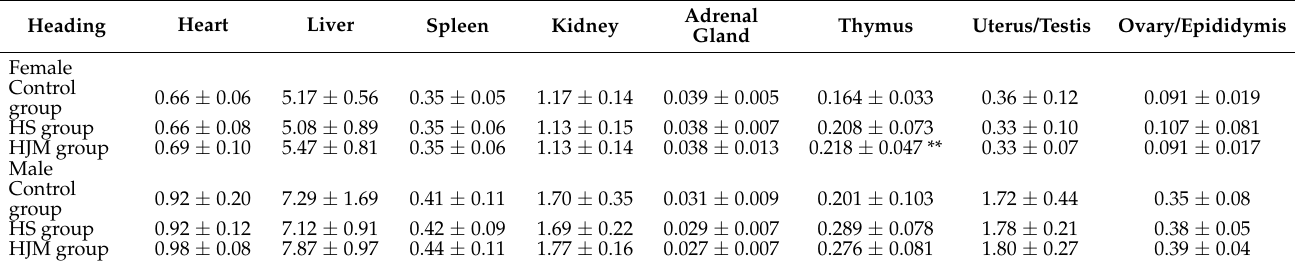
Table 5. Organ/brain weight ratios of male and female rats (mean ± SD).